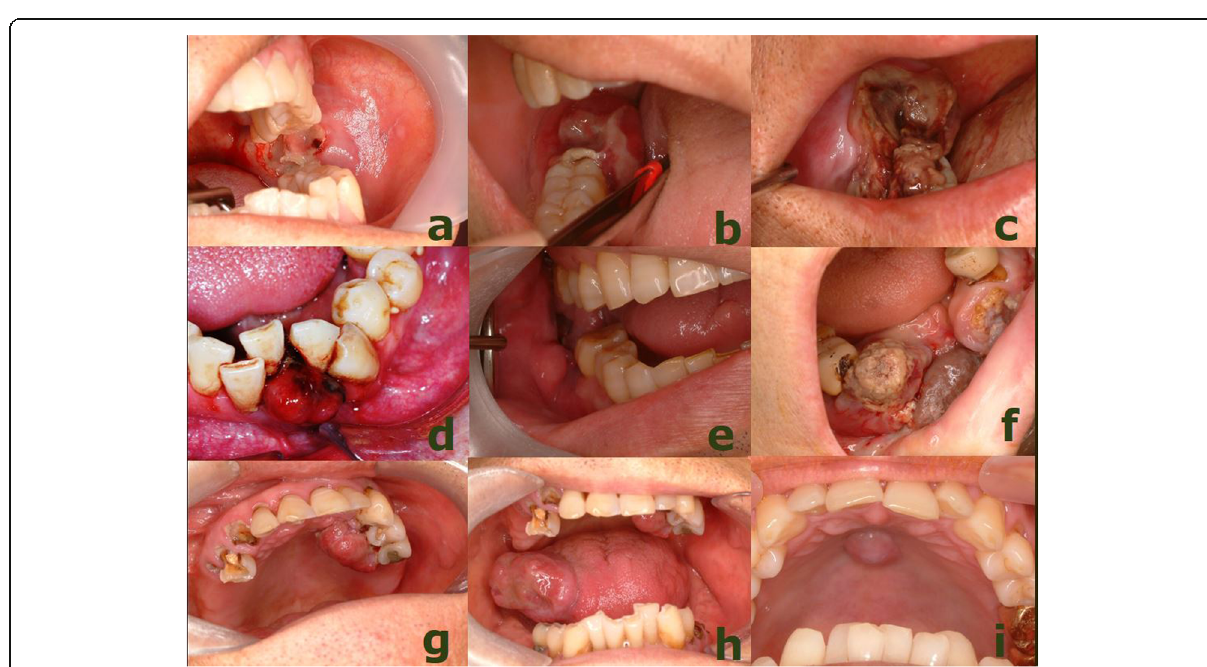
Fig. 1 Oral metastasis by hepatocellular carcinoma. ( a left mandible and retromolar trigone, b , c right mandibular gingiva, d anterior mandibular gingiva, e right mandibular gingiva, f anterior mandibular gingiva, g left maxillary palatal gingiva, h right lateral tongue, i midpalatal mucosa)